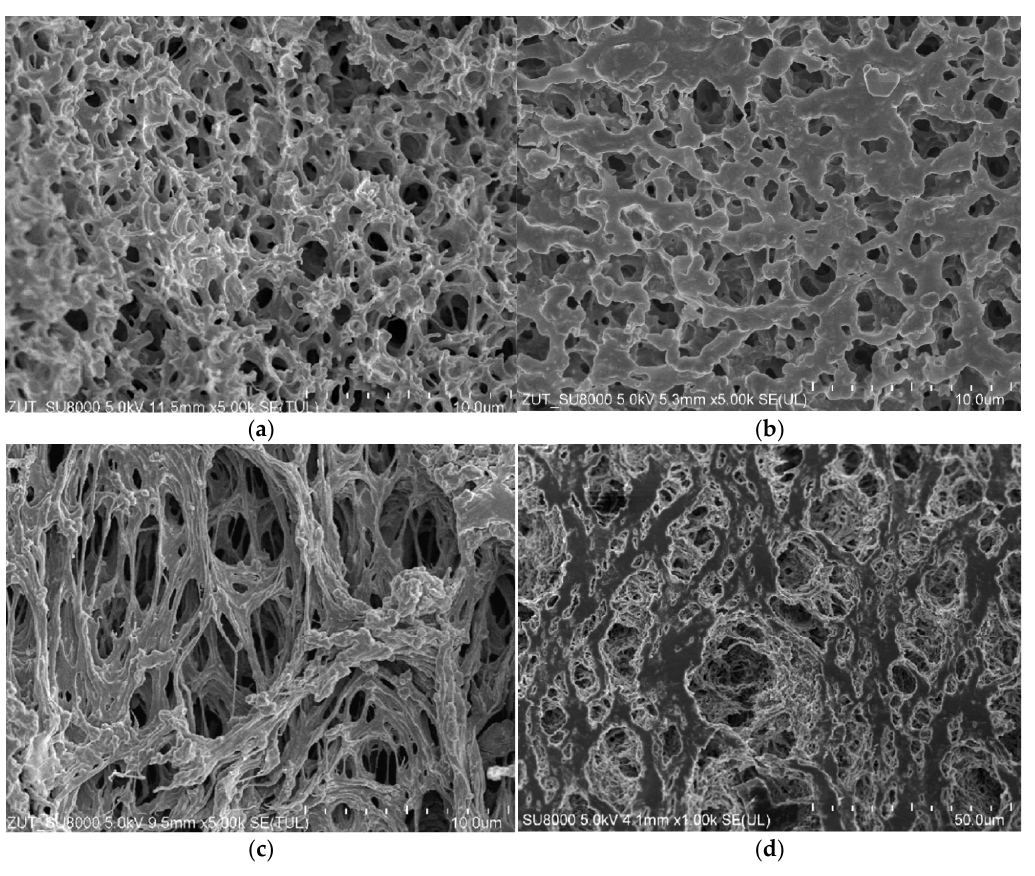
Membranes 2021 , 11 , x FOR PEER REVIEW 18 of 26